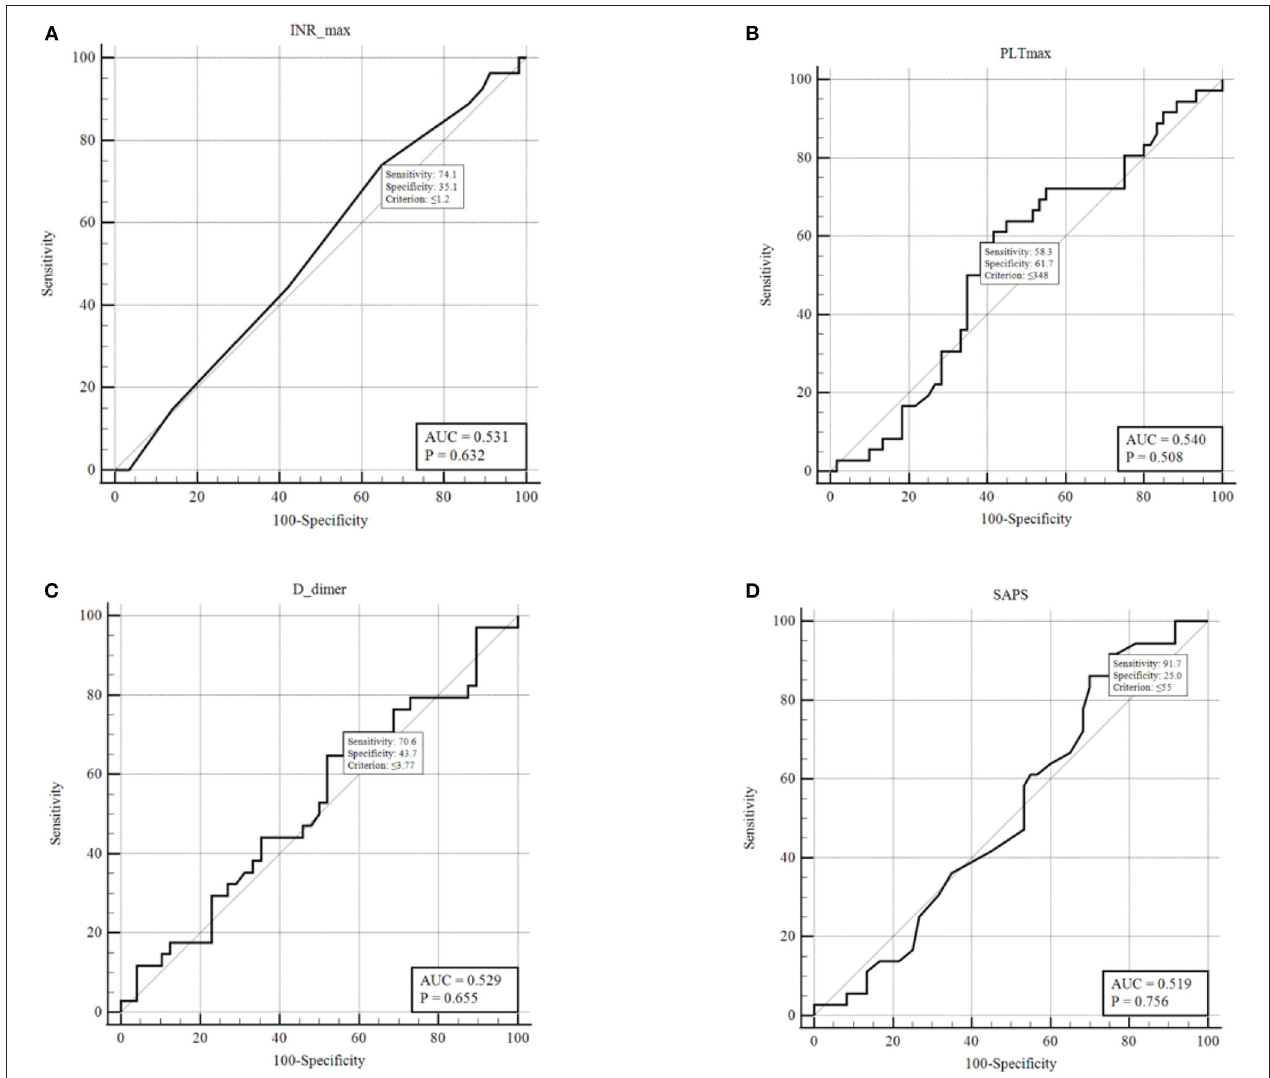
FIGURE 2 | ROC curves for: (A) INR last value pre-DVT or highest value if no DVT; (B) PLT last value pre-DVT or highest value if no DVT; (C) D-dimers last value pre-DVT or highest value if no DVT; (D) SAPS II score within 24h from ICU